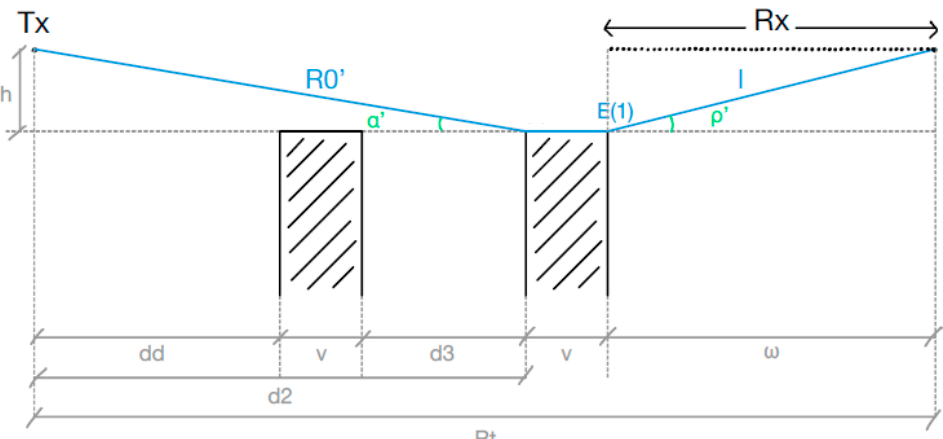
Figure 9. Third double diffraction (Edif_d3) of the considered LOS scenario.